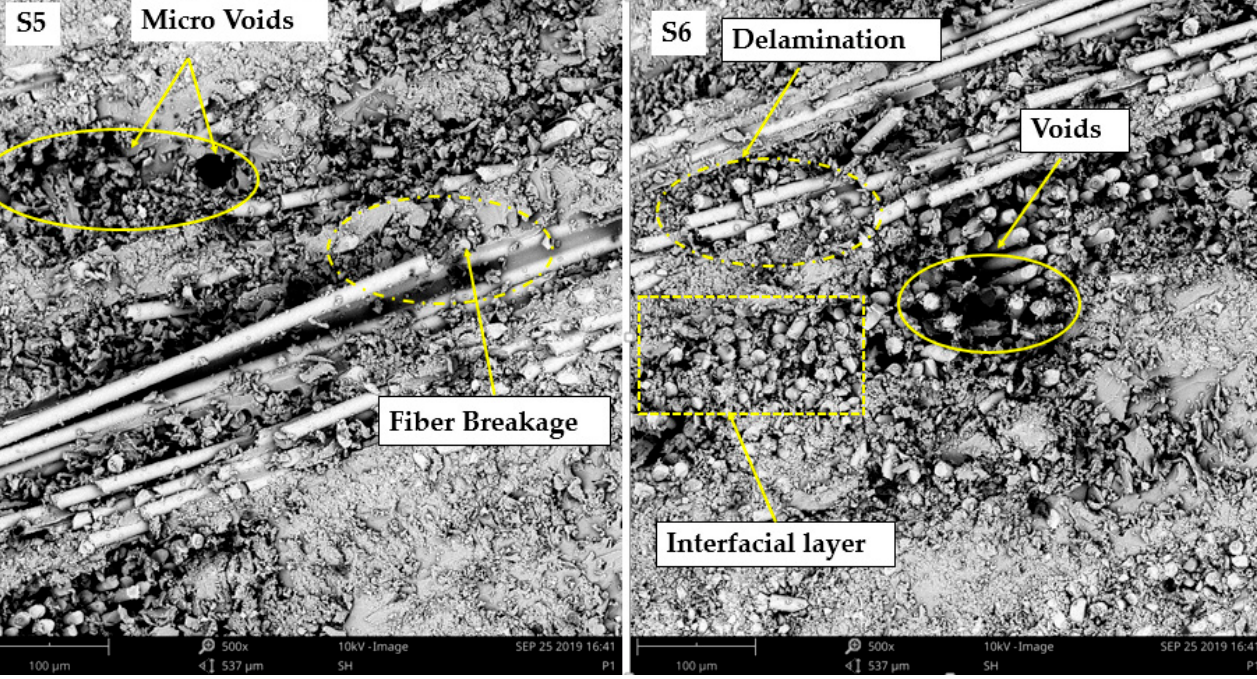
Figure 7. SEM image of S5 and S6 laminate after